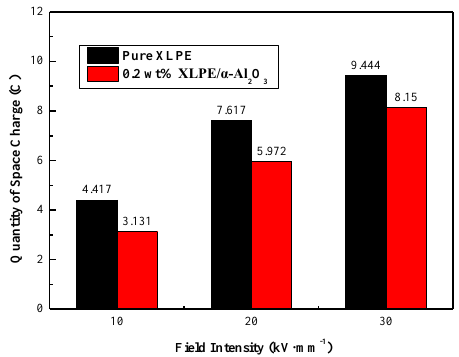
Figure 12. Quantity of space charge of pure XLPE and 0.2 wt % XLPE / α –Al 2 O 3 nanocomposites.